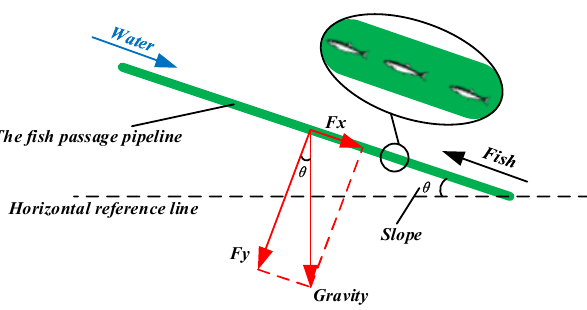
Figure 4. Gravity decomposition diagram of fish passage pipeline.